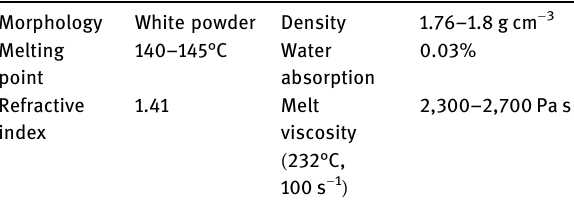
Table 1: The properties of PVDF -